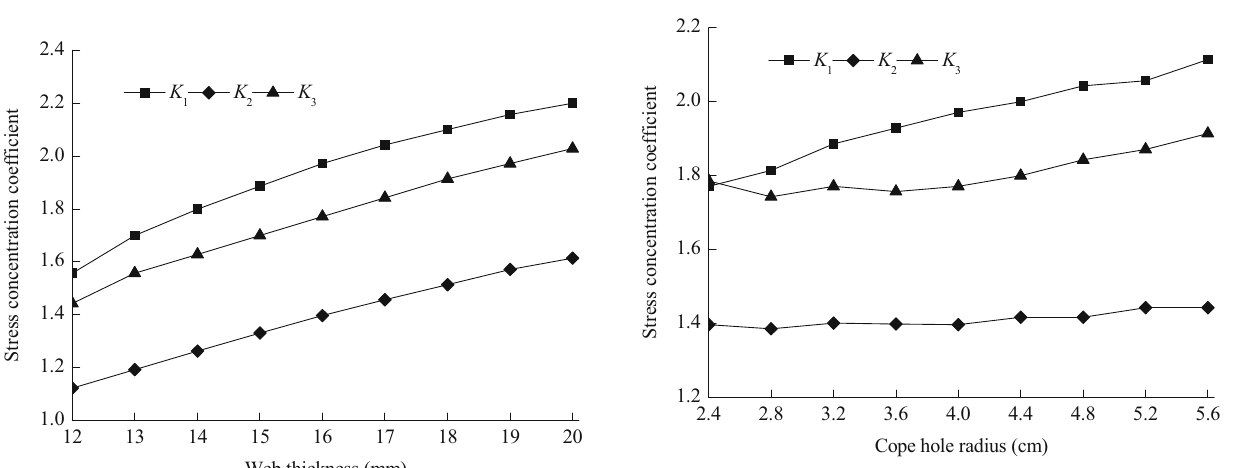
Fig. 6 Relationship between SCC and flange thickness